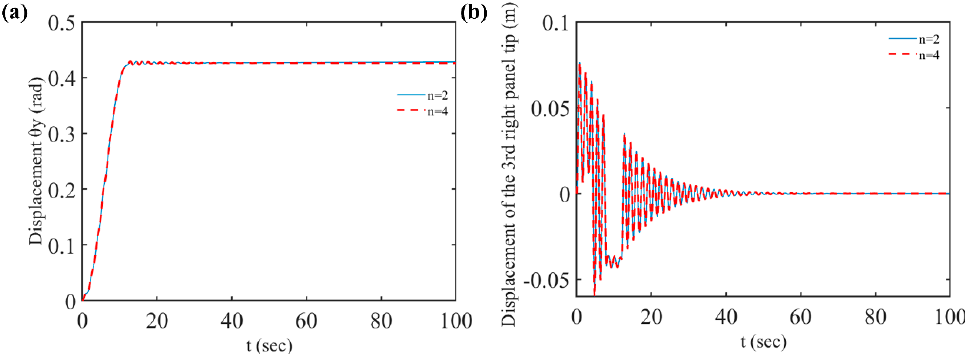
Figure 11. The vibration response of the system ( k ⋅ m= 500N / rad ); they are listed as: ( a ) the displacement of θ ; ( b ) the displacement of the 3rd-right panel tip.